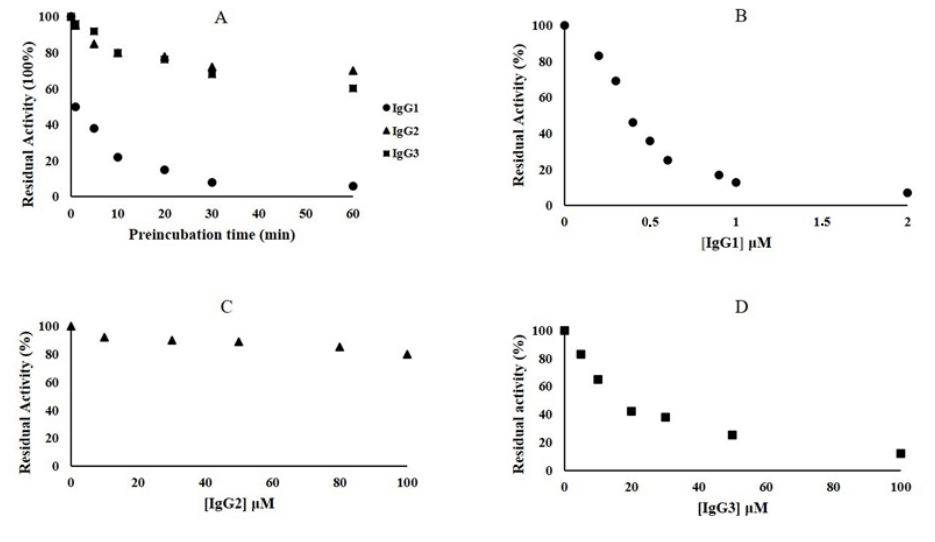
Figure 4. Inhibition e ff ect of IgG1, IgG2, and IgG3 toward NDM-1. ( A ) Time-dependent inhibition assays of the three antibodies toward NDM-1; ( B ) residual activity (%) of NDM-1 after incubation (1 min) with increasing concentration of IgG1; ( C ) residual activity (%) of NDM-1 after incubation (60 min) with increasing concentration of IgG2; ( D ) residual activity (%) of NDM-1 after incubation (60 min) with increasing concentration of IgG3. Each kinetic value is the mean of three di ff erent measurements; the standard deviation (SD) was below 2%.